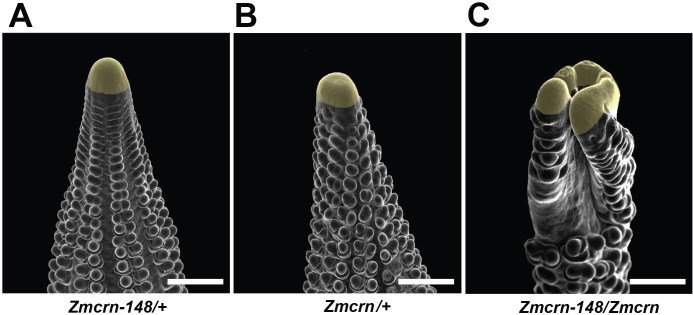
Zmcrn/Zmcrn-148 F1 plants develop fasciated ears.Scanning electron microscopy image of a Zmcrn/Zmcrn-148 F1 ear shows an enlarged ear inflorescence meristem (C), compared with normal ears of Zmcrn-148/+ (A) or Zmcrn/+ (B), suggesting that these mutations are allelic. Scale bars: 500 μm.